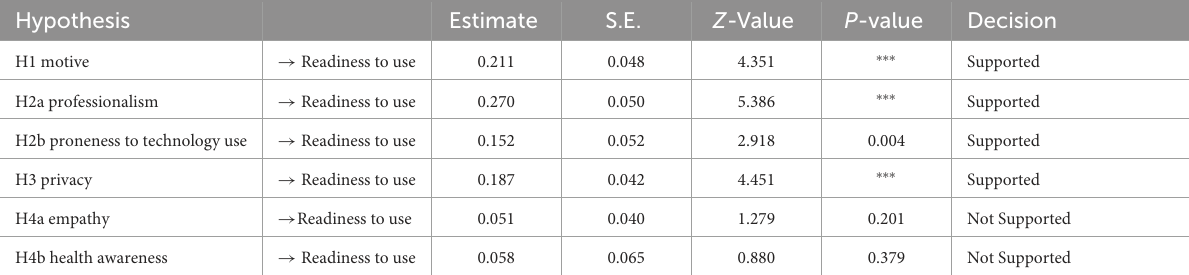
TABLE 4 Hypothesis test